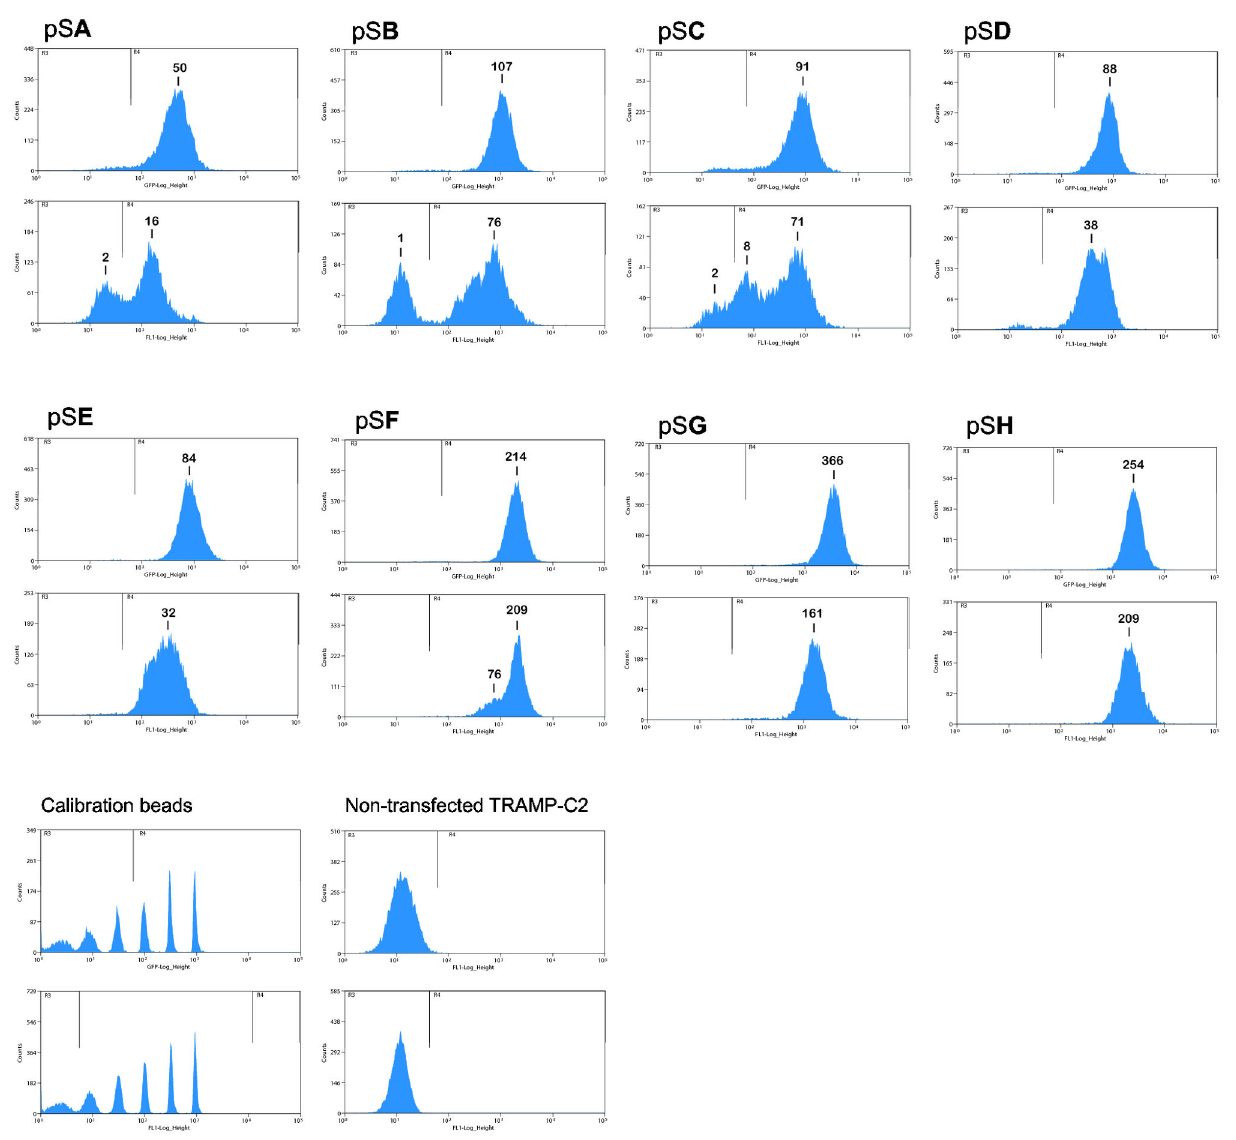
Figure 2. piggyBac transposon-based, insulated reporters are stably expressed in TRAMP-C2 line. Vectors pS A through pS H were co-transfected with the Super pB transposase plasmid into TRAMP-C2 cells. The transfects went through several rounds of FAC sorting, until the maximum fluorescence have been achieved (the upper histogram in each pair). The sorted cells were then let to proliferate without any selection and were subcultured twice a week. The lower histogram in each pair represents FACS analyses of the cells at the end of the 4-month term. Immediately before the analyses, the FACS instrument settings were calibrated against Sphero Rainbow Beads. Median fluorescence intensities in the transfected cells are normalized for the non-transfected control TRAMP-C2